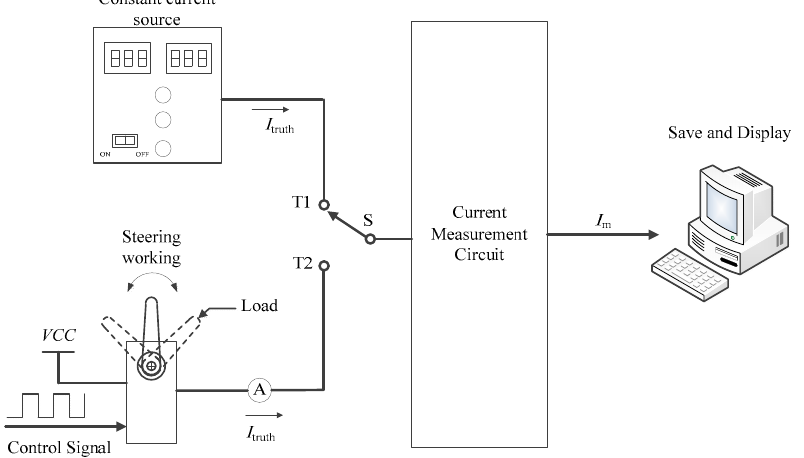
Figure 9. Experimental setup for testing current measurement performance of the proposed method.